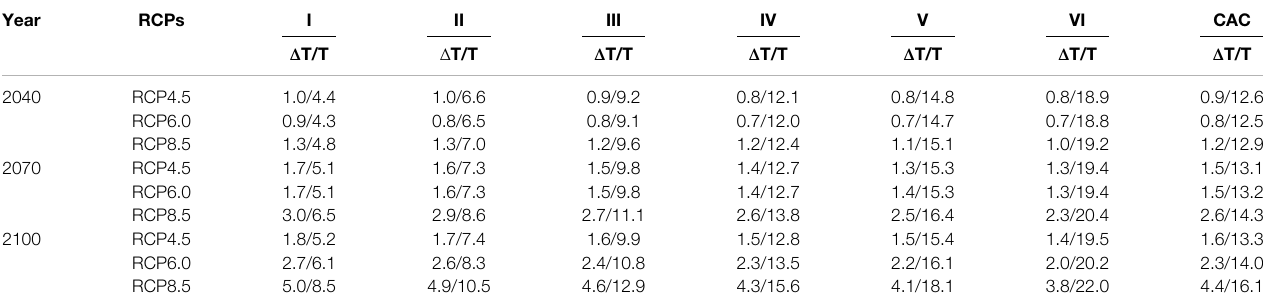
TABLE3| ThechangesofannualaverageTminrelativetothebaseperiod1996 – 2018andtheprojectedannualaverageTminfor2040,2070,and2100withdifferentRCPs over CAC (Unit: ° C).